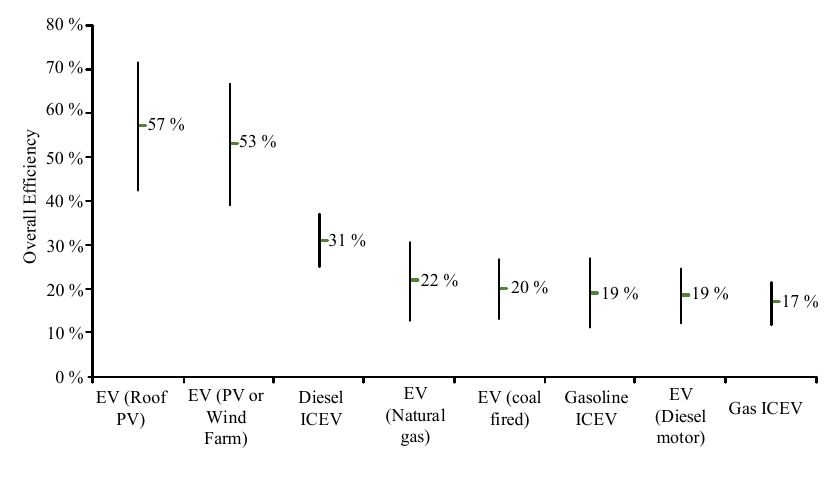
Fig. 6. Overall efficiencies for different cars powered from different